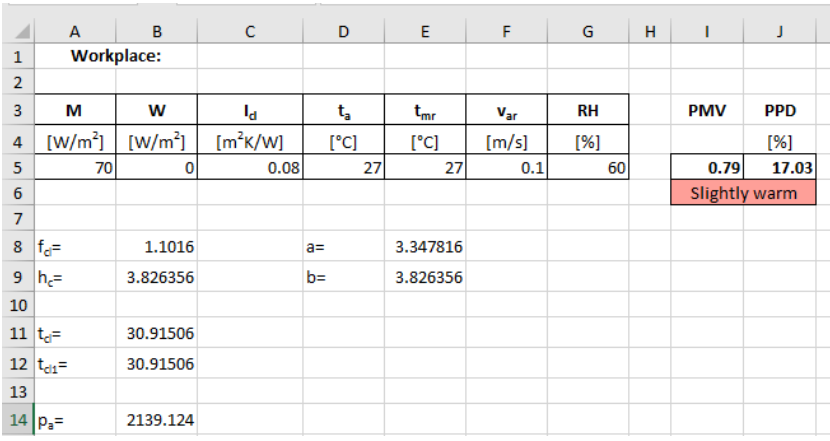
Figure 2. Software instrument for calculating the values of PMV and PPD . Table 1. Calculated cells and their corresponding formulas.